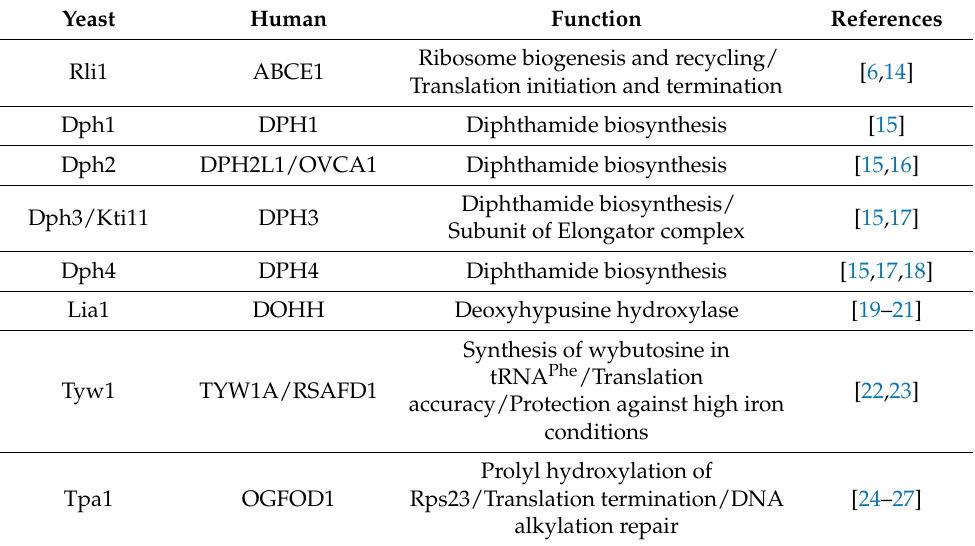
Table 1. List of the iron-containing enzymes involved in translation in the yeast S. cerevisiae . Human homologs, functions, and references are